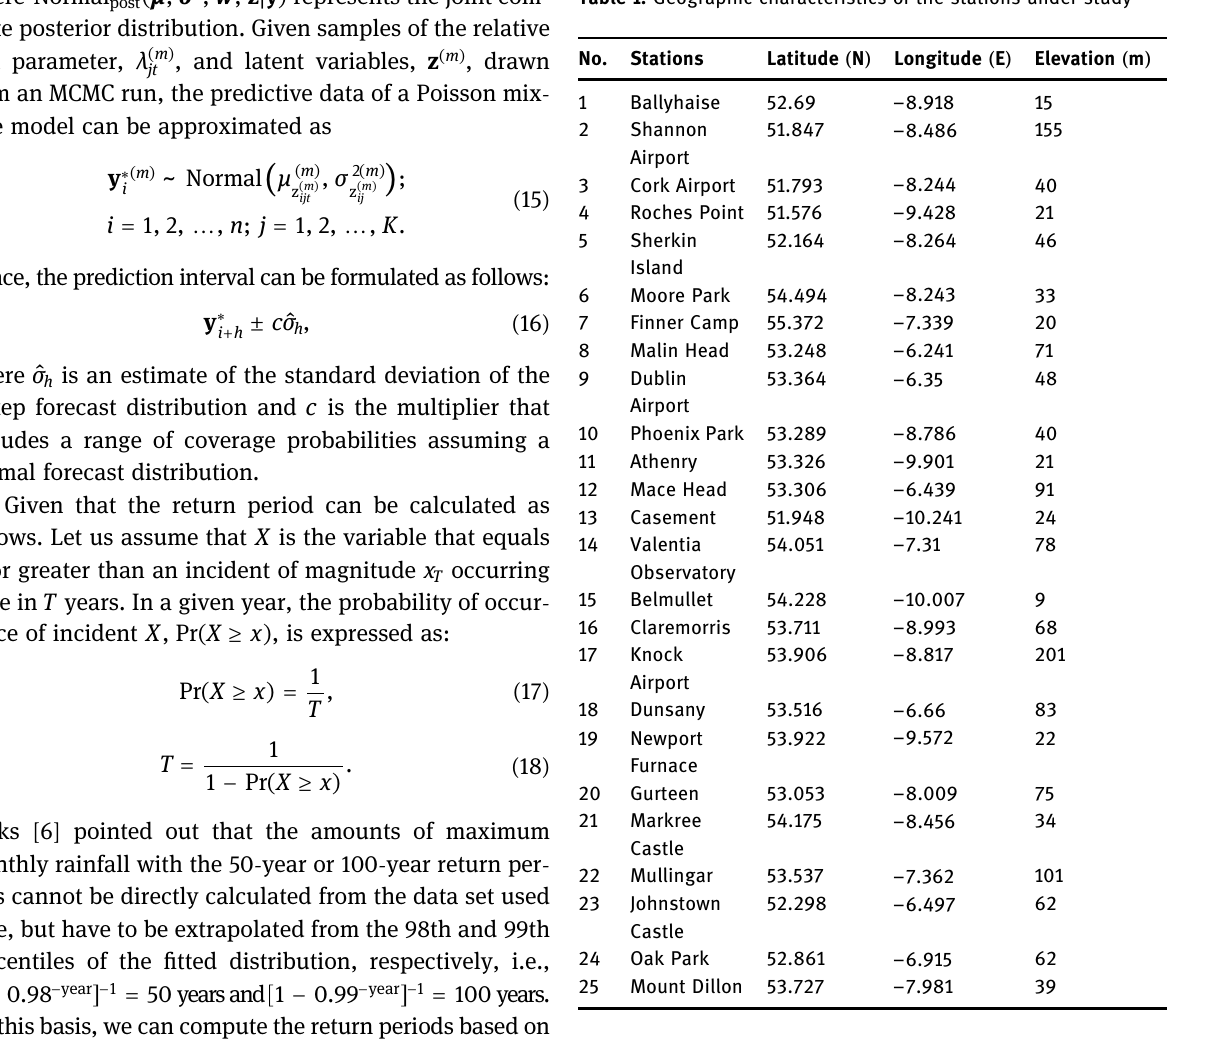
Table 1: Geographic characteristics of the stations under study